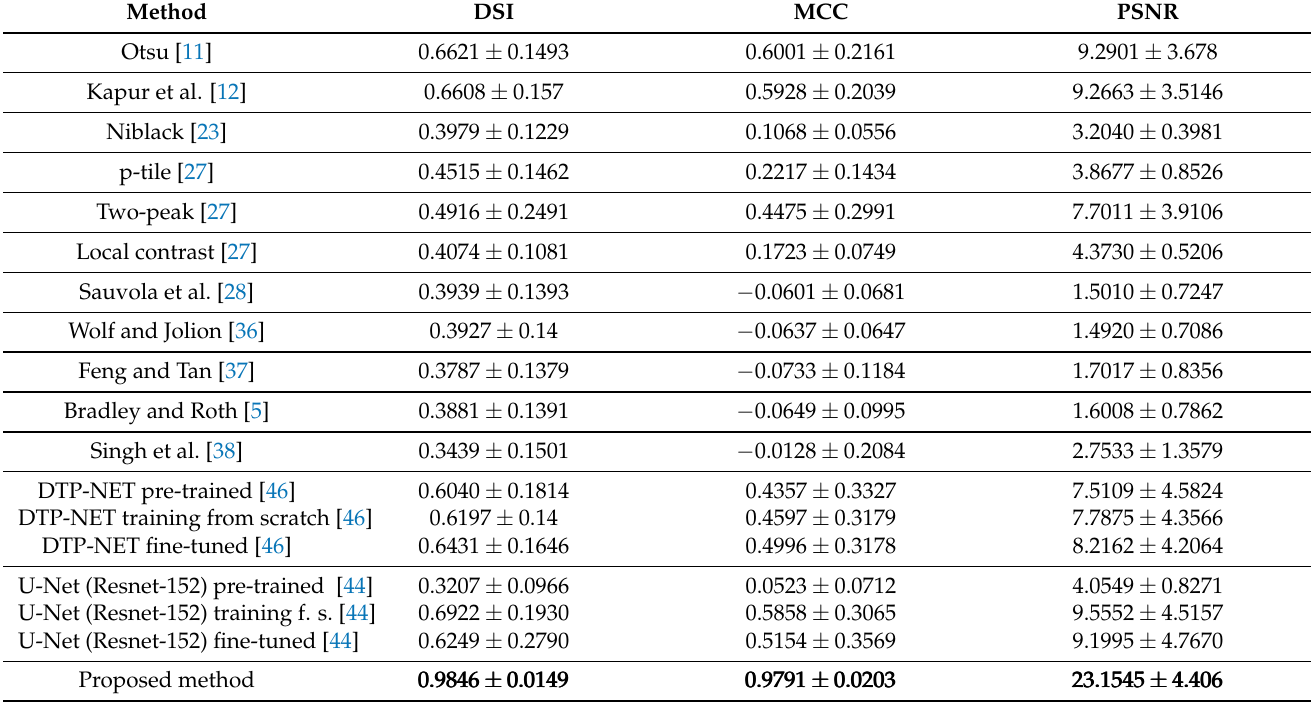
Table 2. DSI, MCC, and PSNR scores for the PCA board dataset of 50 images used to test various thresholding techniques. The highest performance values are marked with bold